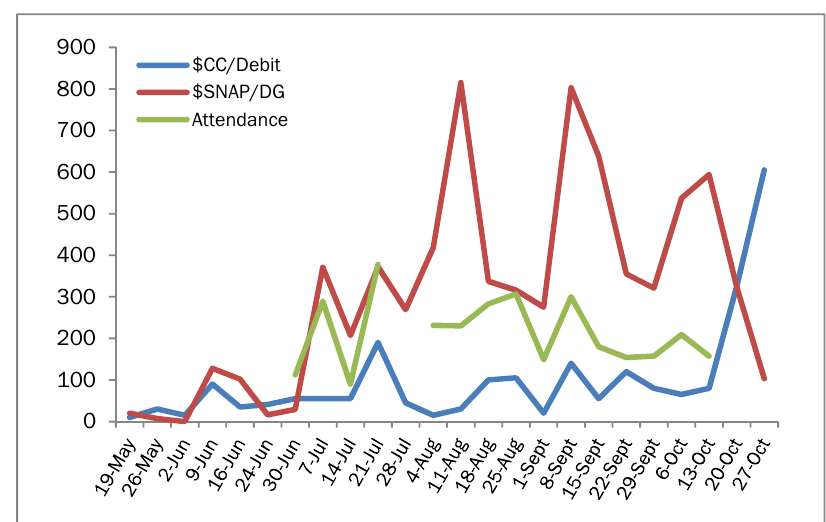
Figure 1. Monthly Attendance, Credit Card and Debit (US$), and SNAP and Double Greens Sales (US$) for the 2011 Season